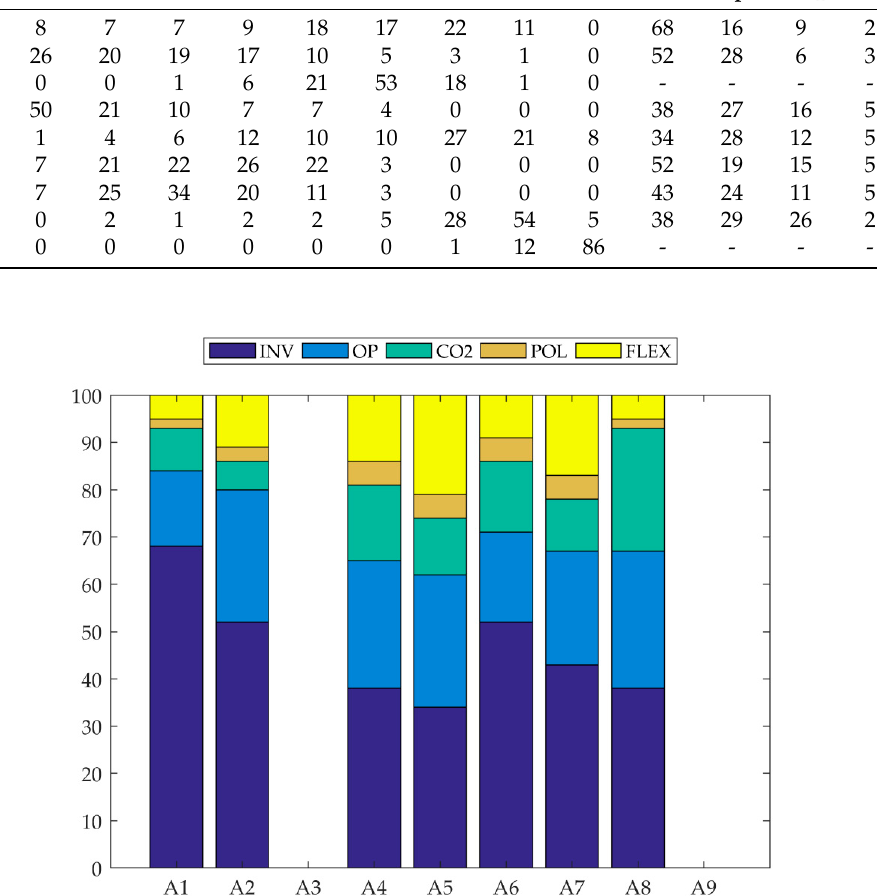
Figure 7. Central weights of the alternatives (%). Table 8. Confidence factor, rank acceptability indices and central weights for the alternatives.